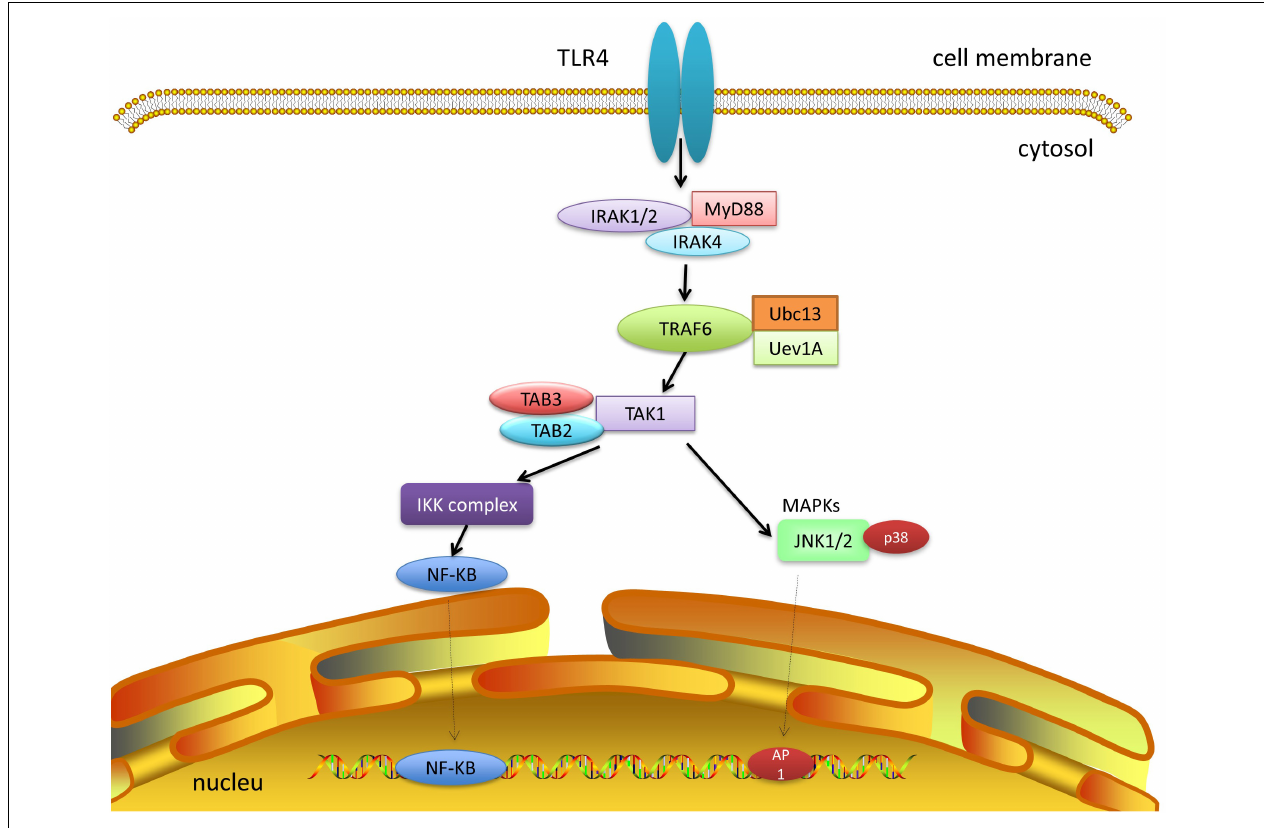
FIGURE 1 | TAK1 signaling. TAK1 signaling is activated after ligand binding to the receptors. TLRs signaling recruits adaptor proteins myD88, which provides a platform for the recruitment of IRAK1/2 and IRAK4. These complexes continually recruit TRAF6, Ubc13, and Uev1A, which bind to TAB2 and TAB3 and lead to the activation of TAK1. Activated TAK1 mediates multiple signal transduction such as MAPK and NF- κ